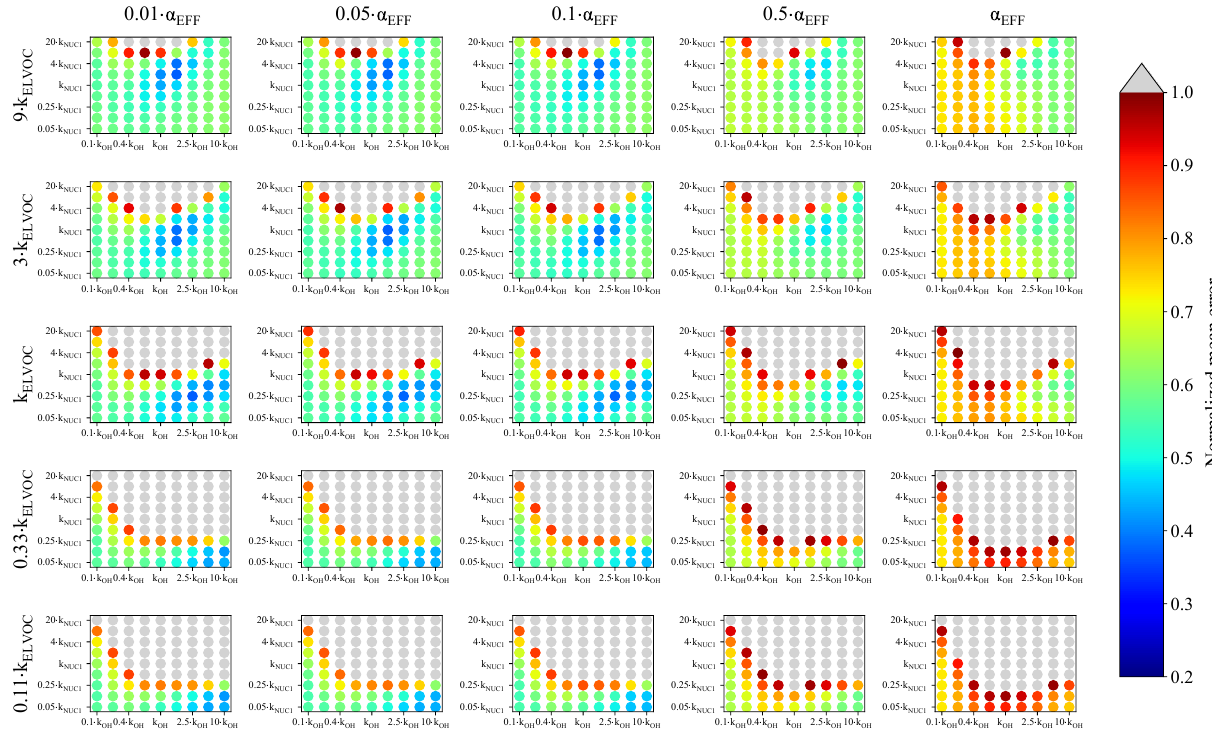
Figure 4. Representation of the parameter space for the average across the 0.09–0.9 day eq. aging exposures from BEACHON-RoMBAS examined in this study for the NUC1 nucleation scheme and base value of the reactive uptake coefficient of 0.6. The effective accommodation coefficient increases across each row of panels; the rate constant of gas-phase fragmentation increases up each column of panels. Within each panel, the rate constant of gas-phase reactions with OH increases along the x axis and the rate constant for nucleation increases along the y axis. The color bar indicates the normalized mean error (NME) value for each simulation, with the lowest values indicating the least error between model and measurement. Grey regions indicate regions within the parameter space whose NME value is greater than 1. No averaged case had a NME value less than 0.2 for the cases shown